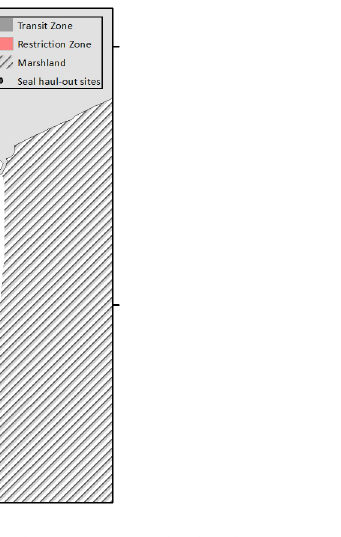
S2 Table. Bayes factor for differences between the posterior proportions of the high inten- sity reactions, by sampling year. SD = standard deviation. The probability that the first year was higher than the second one is also shown.